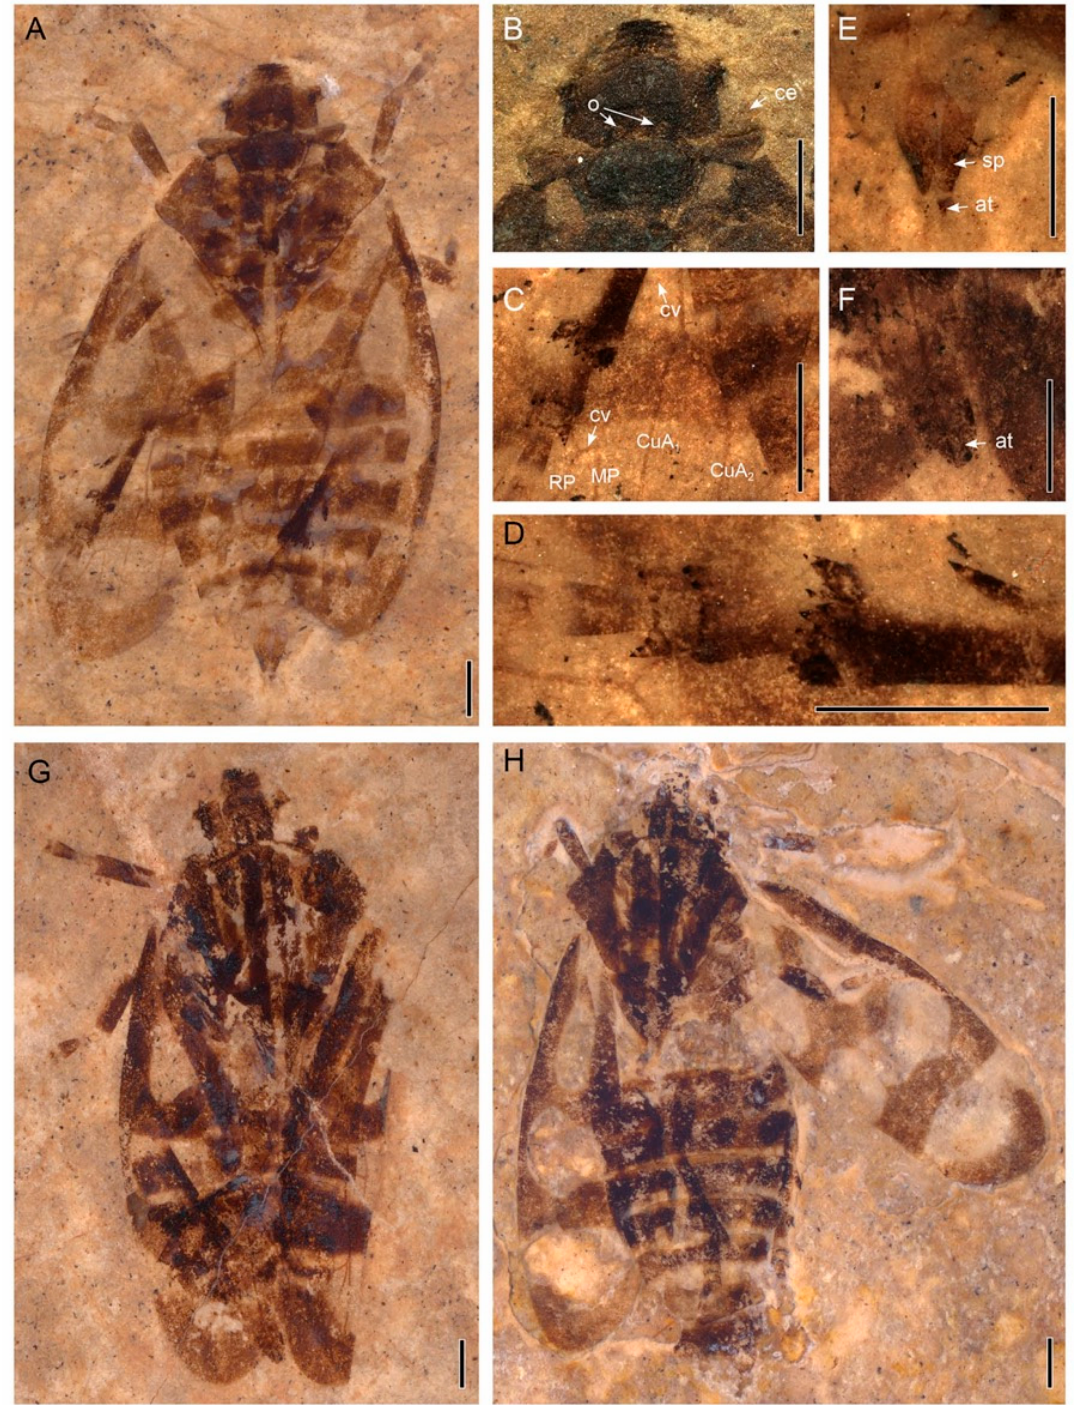
Figure 2. Photographs of the Nangamostethos tibetense gen. et sp. nov. ( A ) Body, XDB3-1209, holotype, male. ( B ) Enlargement of ( A ), showing details of the head. ( C ) Enlargement of the hind wing of XDB3-1209, showing details of the veins. ( D ) Enlargement of A, showing the details of the tip of the hind leg. ( E ) Enlargement of ( A ), showing the details of the male terminalia. ( F ) Enlargement of ( G ), showing the details of the female terminalia. ( G ) Body, XDB3-0252A, paratype, female. ( H ) Body, XDA2-0430A, paratype. At, anal tube; ce, compound eye; CuA, cubital anterior; cv, cross vein; MP, media posterior; o, ocelli; RP, radius posterior; sp, subgenital plate. The specimens were immersed into alcohol except in ( B ). Scale bars: 1 mm.